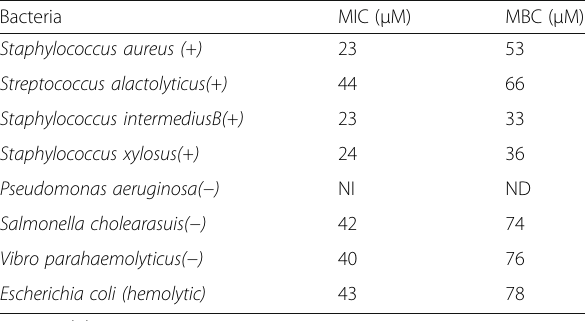
Table 1 Bacteriostatic and Bactericidal Activities of 10-HDA against Eight Different Animal- and Human-Specific